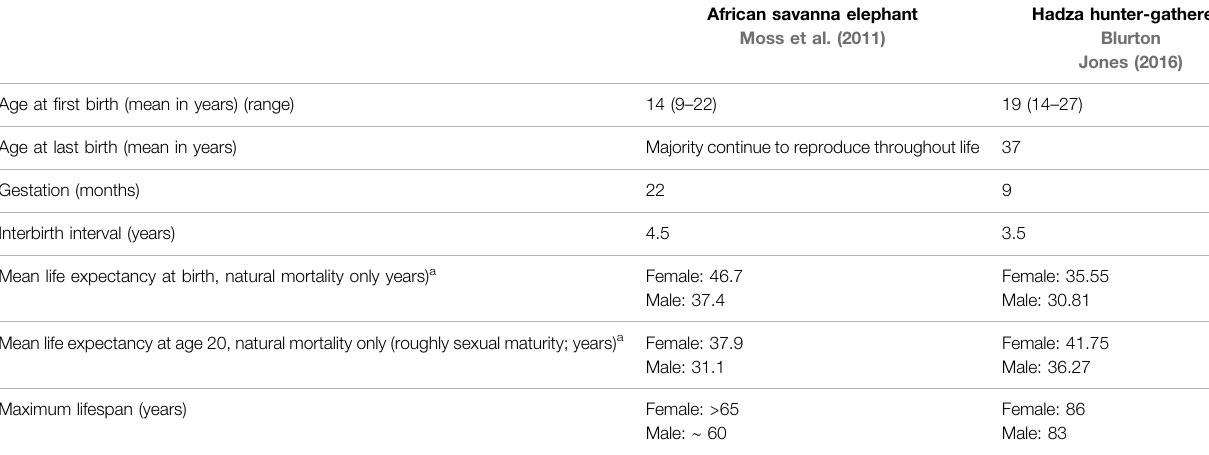
TABLE 1 | Comparative life history of the Amboseli, Kenya, African savanna elephants and Hadza hunter-gatherers.